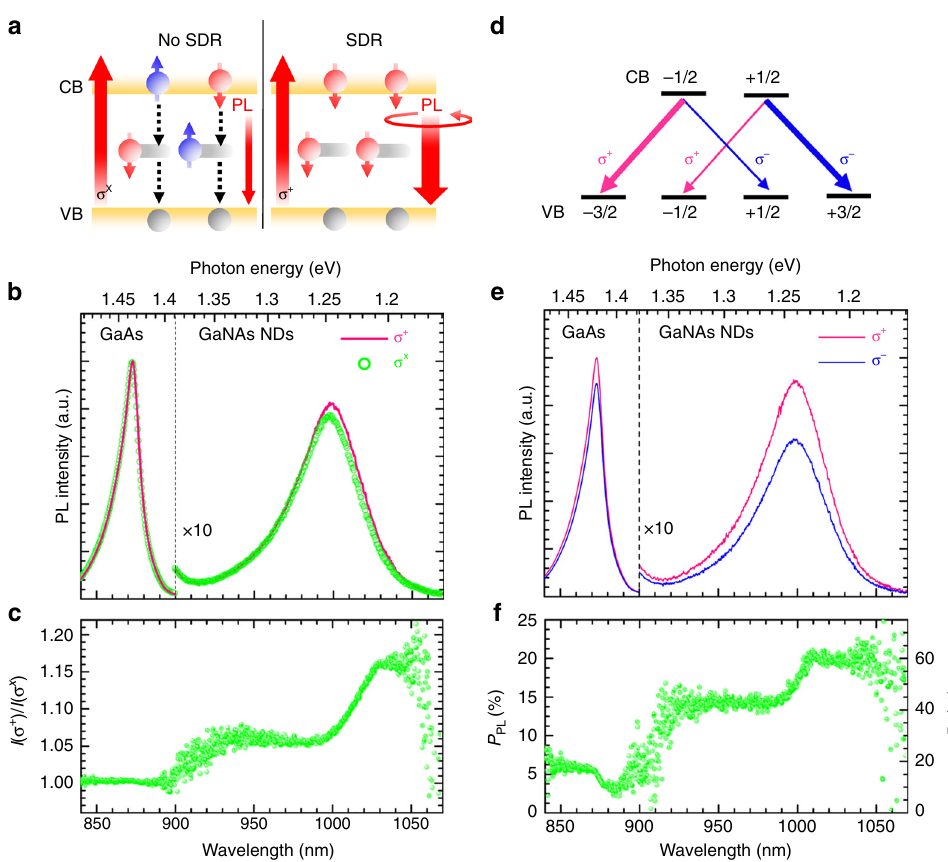
Fig. 3 Ef fi cient room temperature spin generation enabled by few defects. a Schematic illustration of the defect-driven spin generation via spin-dependent recombination (SDR) under σ + excitation (the right panel), which shows stronger and co-polarized photoluminescence (PL) than that without the SDR effect under σ x excitation (the left panel). The gray horizontal bars represent the defect level. b PL spectra excited by σ + and σ x laser light. c Spectral dependence of the I ( σ + )/ I ( σ X ) ratio. d Band diagram illustrating the polarized band-to-band transitions involving valence band (VB) heavy-hole (±3/2) and light-hole (±1/2) states. e σ + and σ − polarized PL spectra under the σ + excitation. f Spectral dependence of the PL and conduction band (CB) electron spin polarizaion. In converting P PL – P e , the light depolarization factor arising from the fi nite solid angle of light detection by the microscope objective with the given numerical aperture (NA) has also been taken into account. Since, the PL emission from GaAs is at least partly contributed from the planar GaAs substrate, P e in GaAs could be overestimated by a factor up to